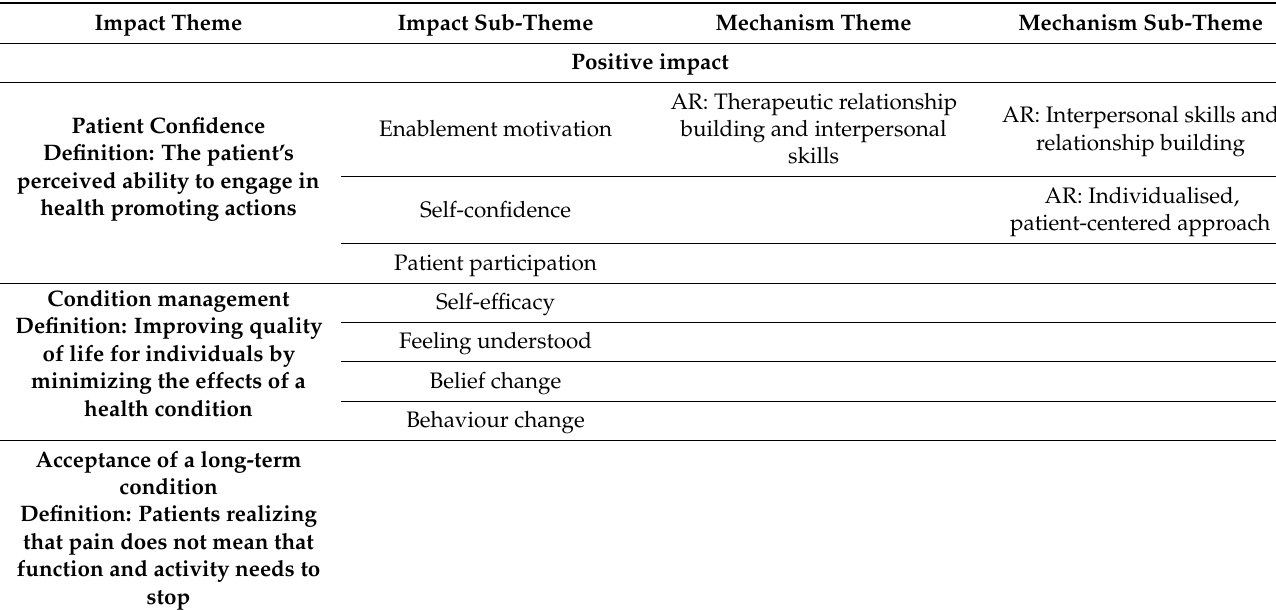
Table 1. Showing the impact and mechanisms associated with reassurance with at least moderate CerQual